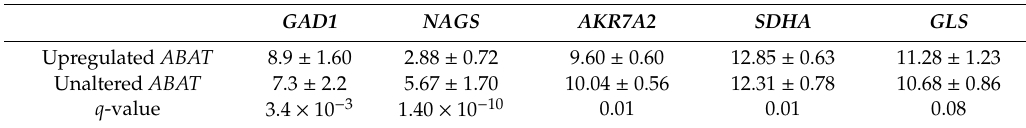
Figure 3. Transcripts altered in samples with upregulated ABAT transcripts. Volcano plot representing log 2 transformation of the ratio of an enriched gene’s average transcript level in the ABAT “upregulated” samples relative to that gene’s average transcript level in the ABAT “unaltered” group of samples ( x -axis = “log ratio”), as plotted against the p -value significance (Unpaired t -test) of each transcript’s enrichment in the “upregulated” samples ( y -axis = log 10 p -value). Gray = q > 0.05; blue = q ≤ 0.05 (Benjamini-Hochberg correction). Generated by cBioPortal, modified. Table 4. Expression of transcripts encoding selected GABA shunt and shunt-proximal genes in ACC tumors with upregulated vs unaltered